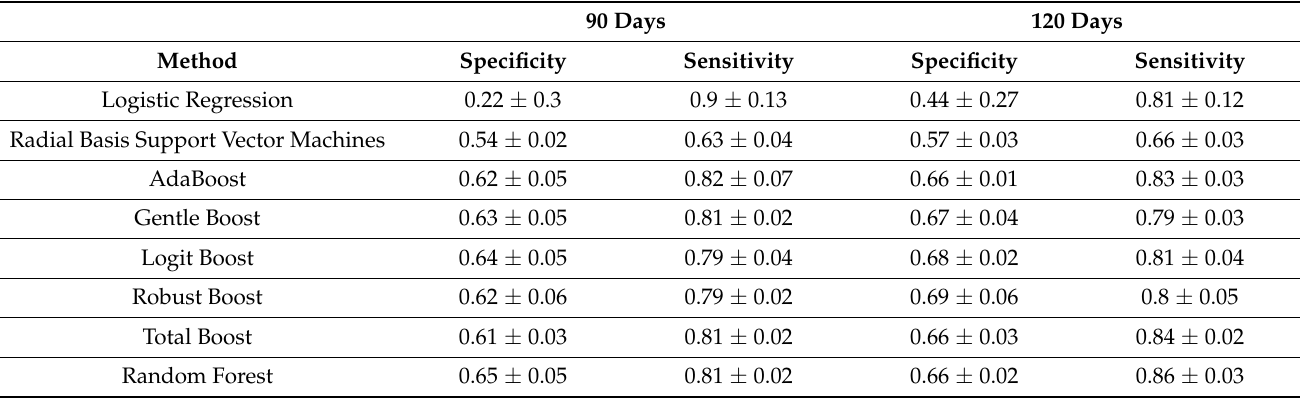
Table 1. Performance of different machine learning classifiers on the prediction of